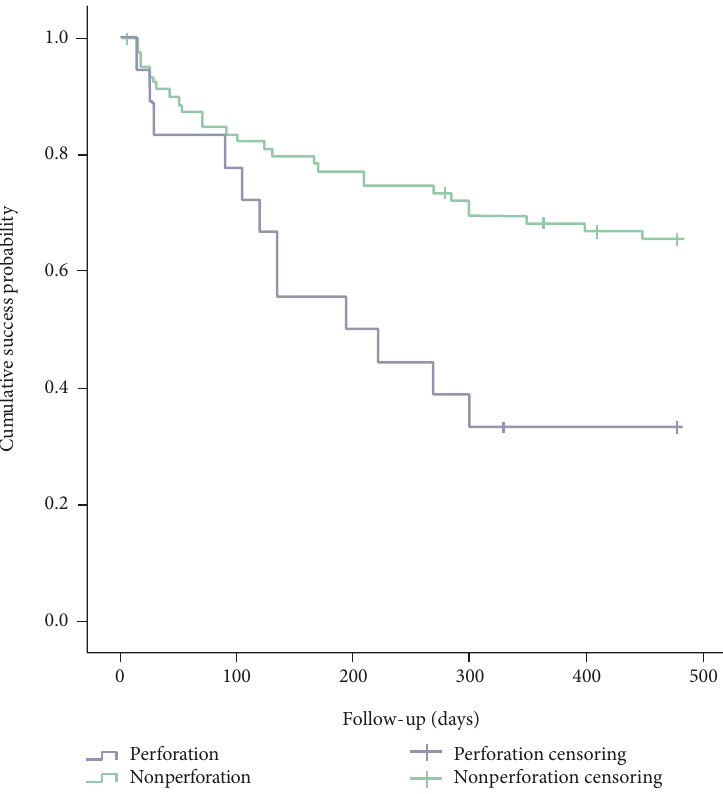
Figure 3: Comparison of survival curve between corneal perforation group and nonperforation